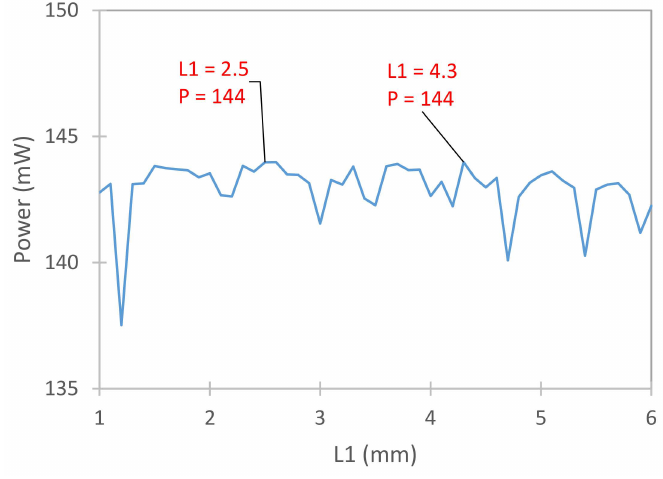
Figure 8. Graph Showing Variation of Power Output with the Length Between the Fixed End of the Cantilever Beam and the Starting Point of the Piezoelectric Layer L 1 .